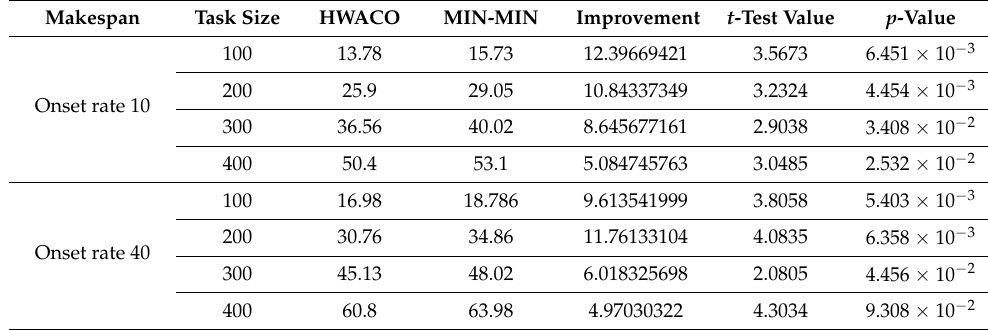
Table 7. t -Test for makespan between HWACO and MIN-MIN.